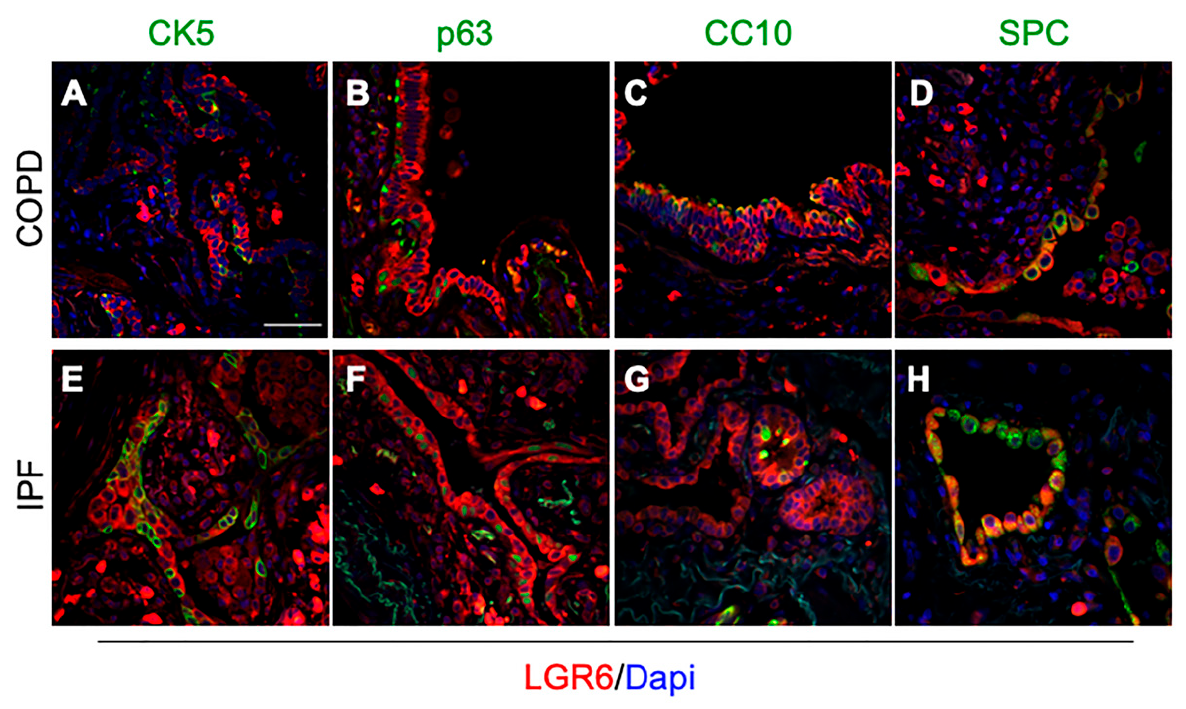
Figure 2. Increased LGR6 expression is observed in epithelial progenitor cells. ( A – H ): Immunofluorescence analyses depicted co-expression of LGR6 (red) and main epithelial progenitor markers (green). CK5 ( A , E ; bar = 50 µ m) and p63 ( B , F ) markers were used to identify basal progenitors, CC10 stained club cells ( C , G ) and SPC was used to recognize ATII cells ( E , H ).